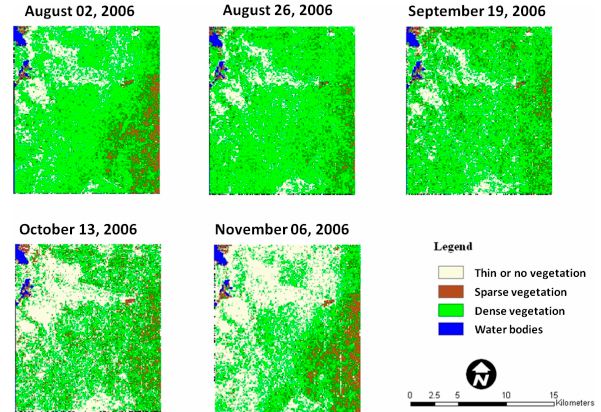
Figure 5. Vegetation density map for each SAR image acquisition date.